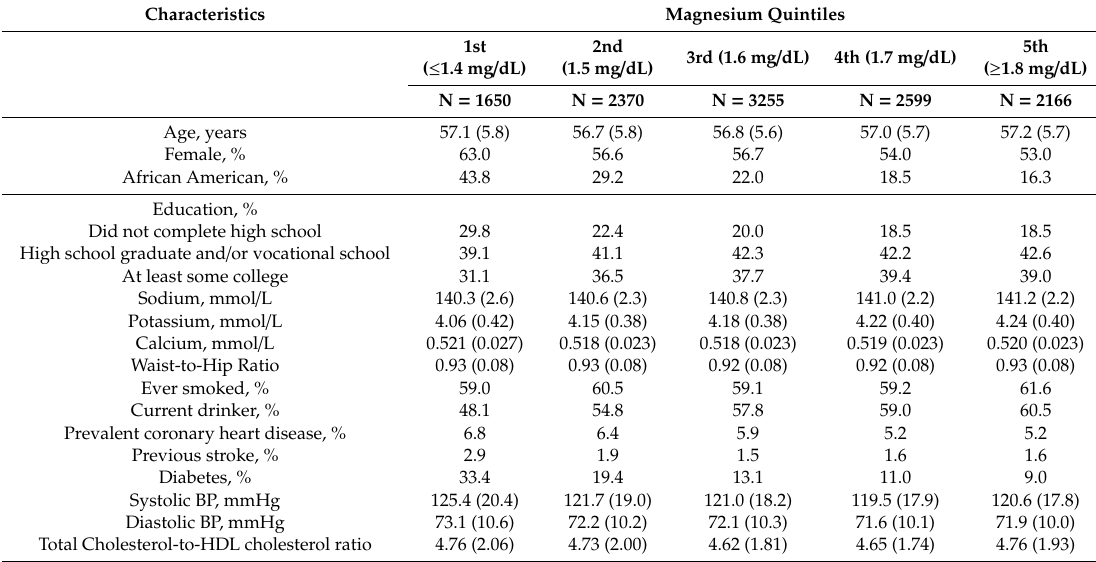
Table 1. Cohort characteristics by baseline magnesium quintile, ARIC